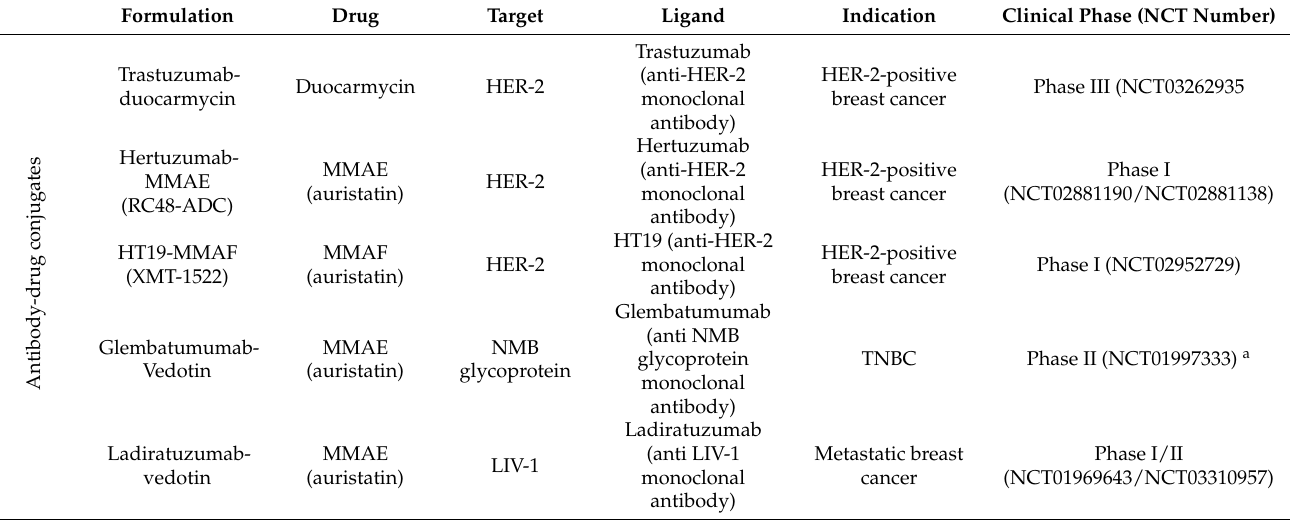
Table 2. Nanomedicines under clinical research in breast